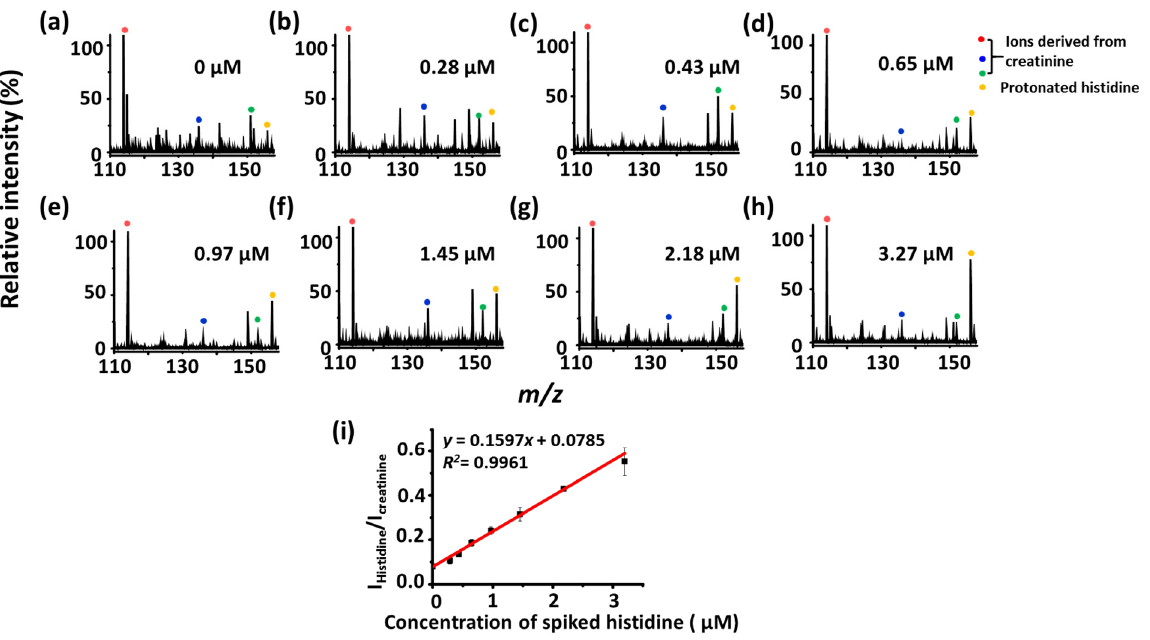
Figure 3. On-line preconcentration of histidine from a 100-fold diluted sample that originally contained histidine (50 µ M) and creatinine (1 mM) combined with the standard addition method for quantitative determination of histidine. ( a – h ) Representative mass spectra of the samples obtained from on-line preconcentration of histidine from aqueous samples spiked with histidine. The creatinine ion peaks m / z 114.07 [M+H] + ), 136.04 ([M+Na] + ), 152.02 [M+K] + )) in the samples were used as internal standard. ( i ) Plot of the ratio of the ion intensity of the peak at m / z 156.07 ( I his , histidine, [M+H] + )) to the sum ( I cre ) of the ions derived from creatinine versus the concentration of spiked histidine. Mass tolerance was set to ±0.01 amu.